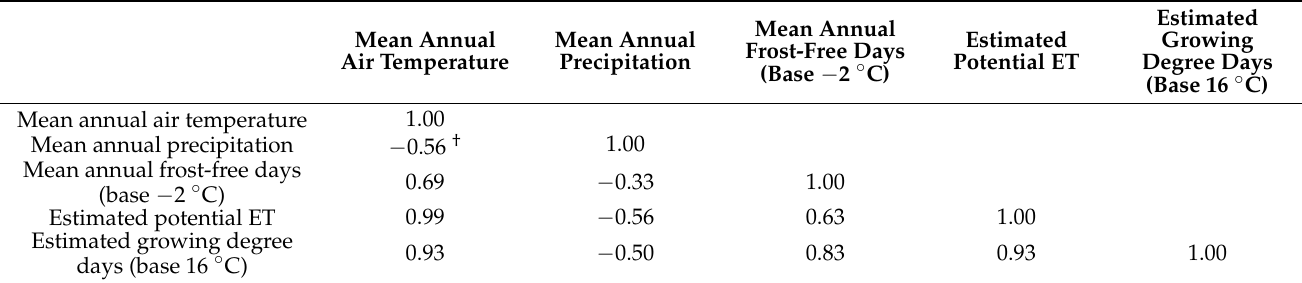
Table 8. Correlation between environmental values associated with soil components in West Virginia (ET